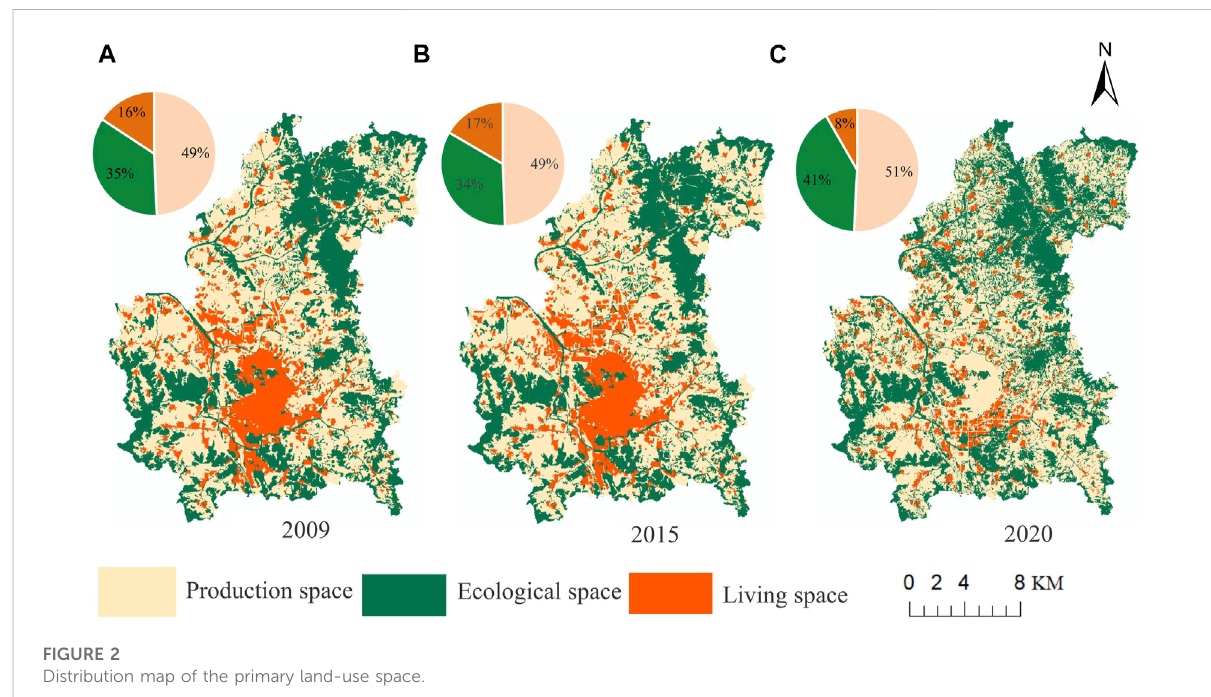
FIGURE 2 Distribution map of the primary land-use space.